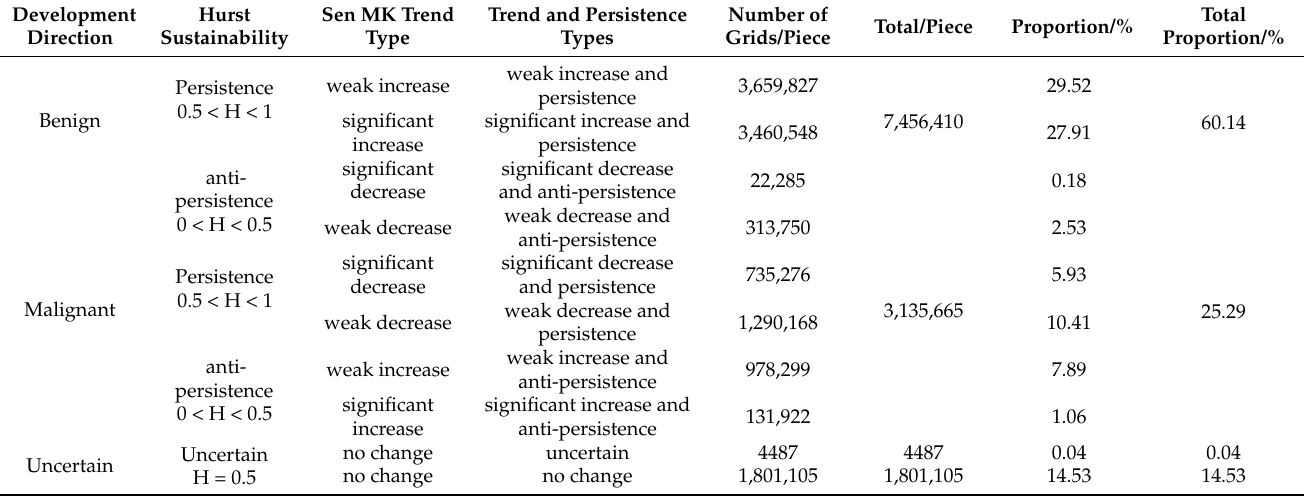
Table 5. Statistics of Sen-MK and Hurst coupling